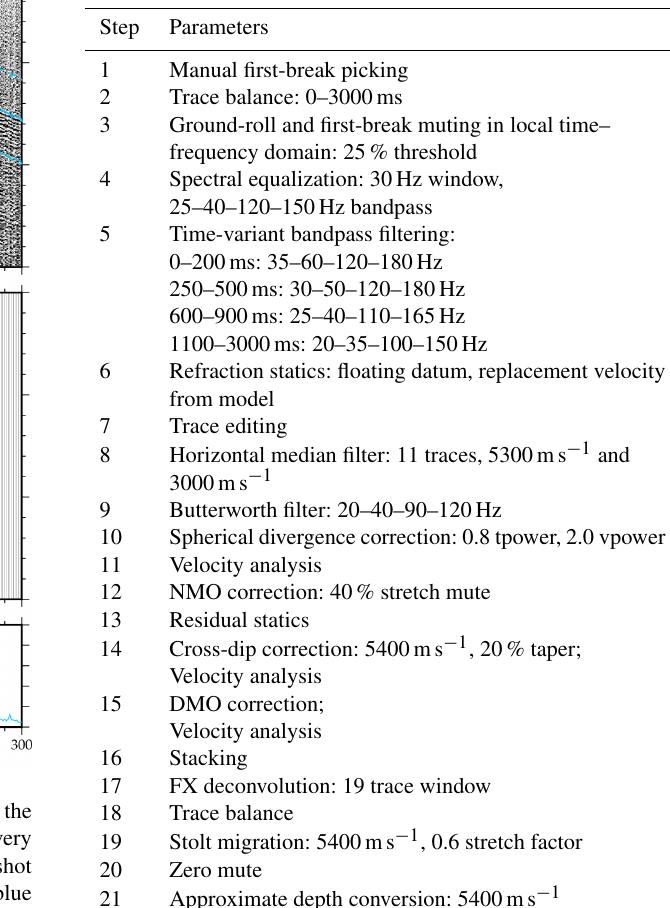
Table 1. Summary of the processing flow used for reprocessing the Burträsk